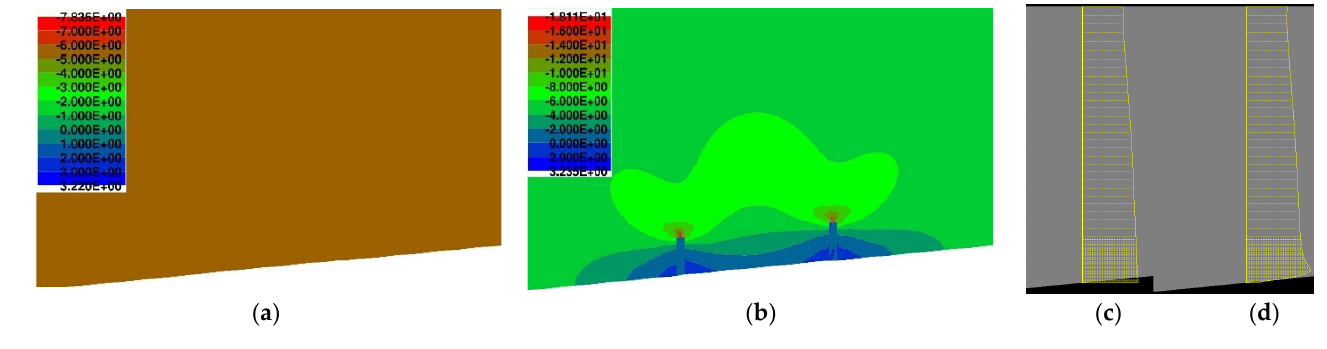
Figure 19. Normal stress [MPa] distribution—before sawing ( a ) and ( c ); after sawing ( b ) and ( d ).